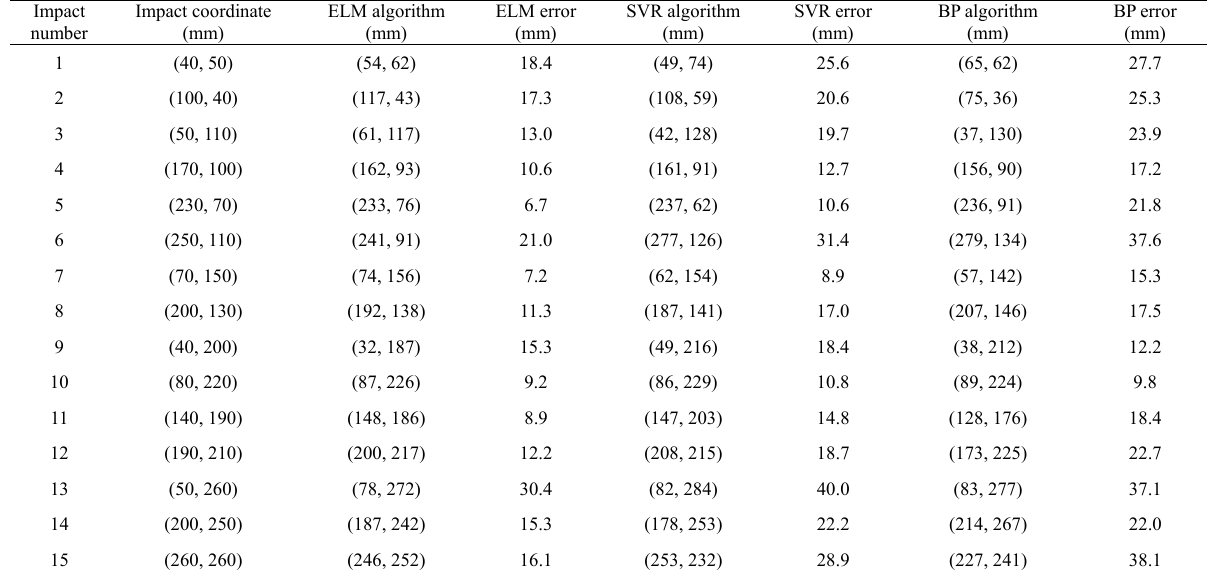
Table 1 Impact localization